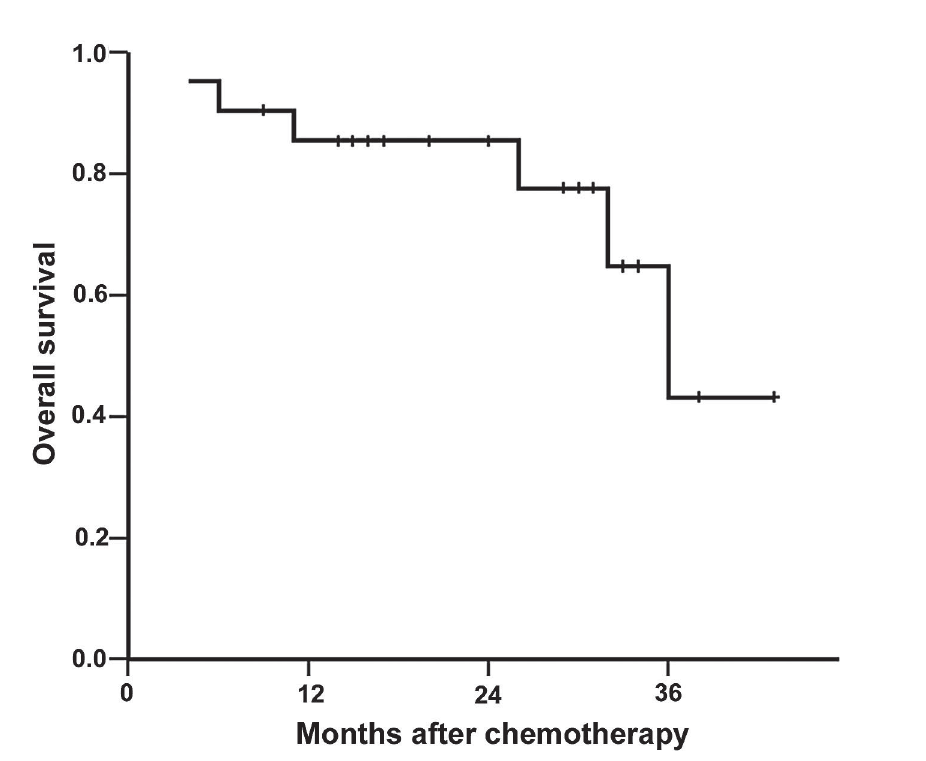
Figure 2 – Overall survival of 21 patients treated with neoadjuvant gemcitabine and cisplatin for invasive bladder